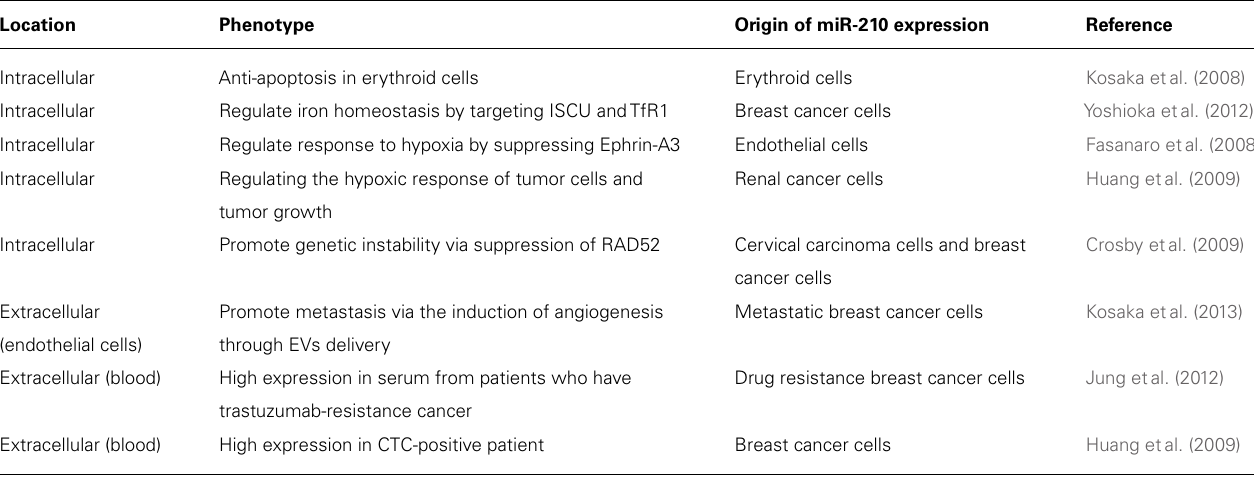
Table 1 |The miR-210 studies in the cells and in the extracellular